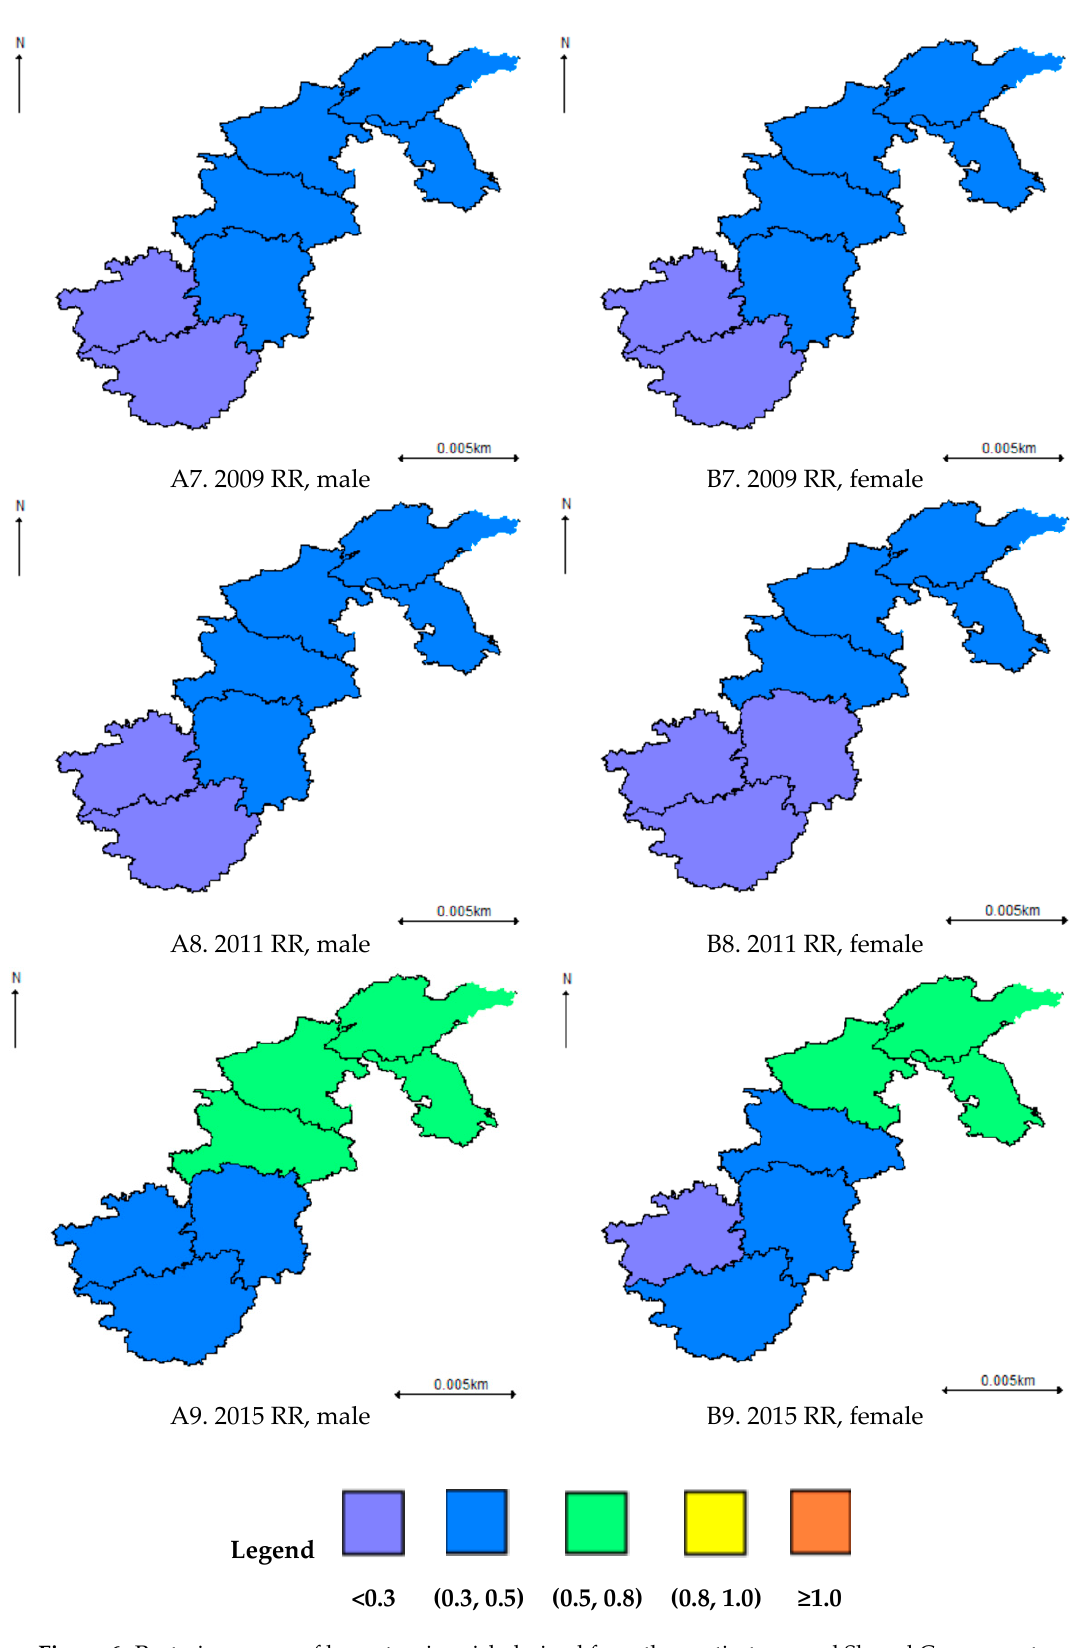
Figure 6. Posterior means of hypertension risk derived from the spatio-temporal Shared Component Model (SCM) model.